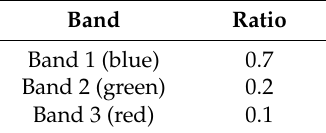
Table 5. The adopted ratios of used bands for TSS mapping by ALOS 18 January 2010